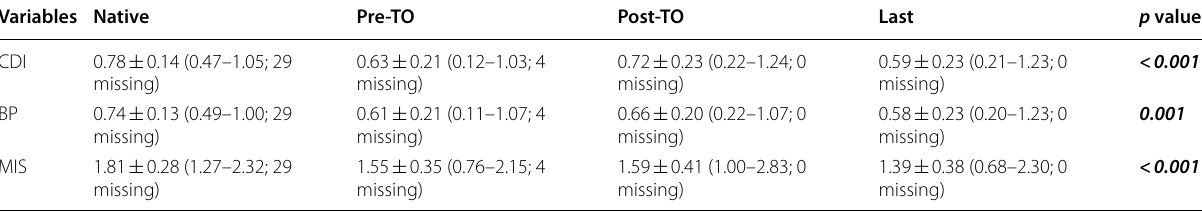
Continuous variables are shown as mean standard deviation (range; number of missing values) ± Significant differences are displayed in bold and italic CDI Caton-Deschamps index, BP Blackburne-Peel ratio, MIS modified Insall-Salvati index, native before total knee arthroplasty, pre-TO immediately before tuberositas osteotomy, post-TO immediately after tuberositas osteotomy, last final follow-up